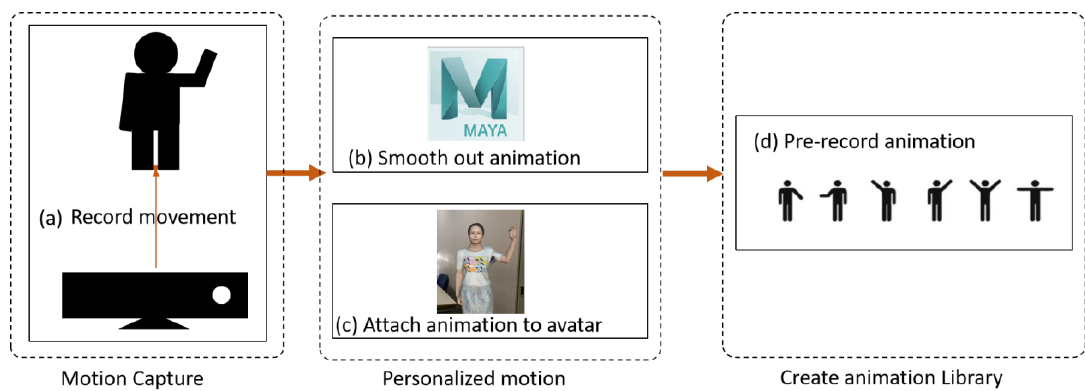
Figure 3. Work flow of recording personalized user